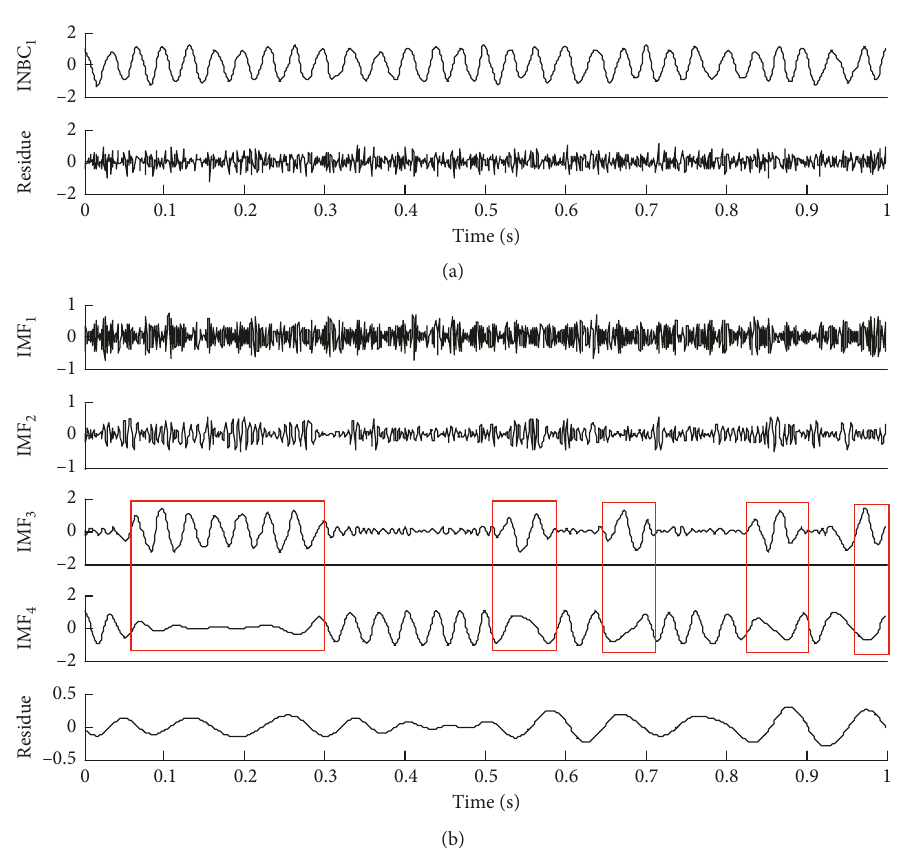
Figure 6: The time-domain waveforms of simulation signal x as SNR 5, 10, 15, respectively; (d) the AM-FM component of x 2 ( n ); (e), (f), and (g) the noise components s ( n ) of the signals shown in (a), (cid:29) (b), and (c), respectively.